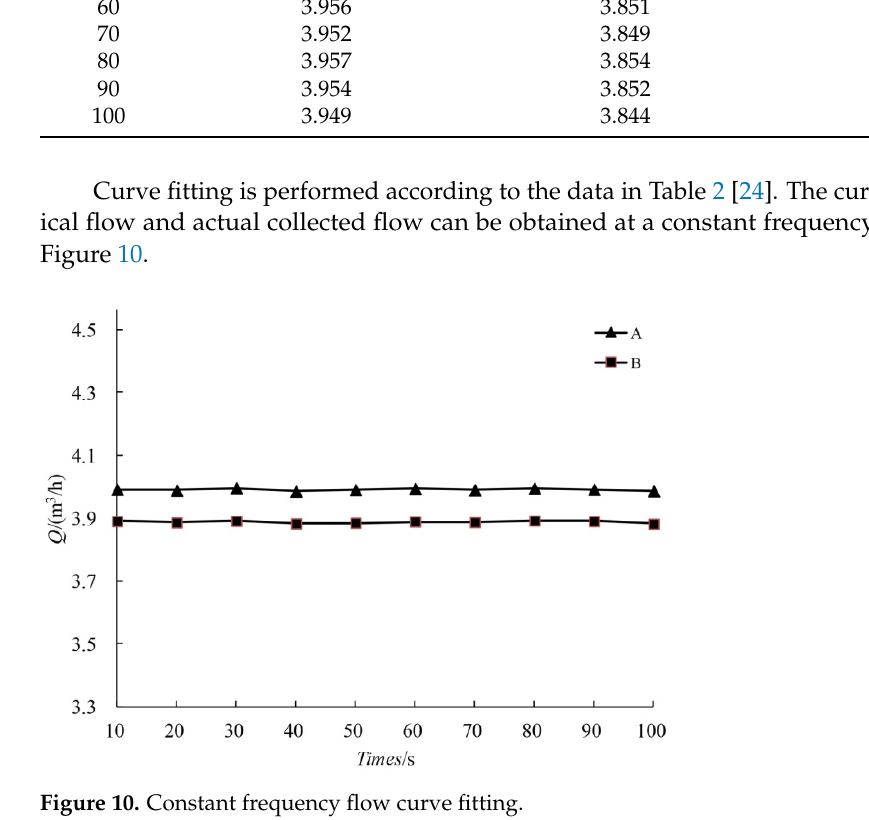
Figure 10. Constant frequency flow curve